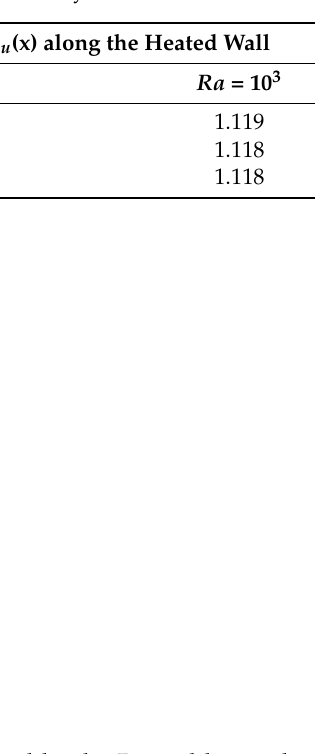
Figure 3. Numerical results comparison with the analytical solution of Shih and Tan [32]. In addition, the average Nusselt number on the hot wall is correlated with the established results (see in Table 2) developed by Chen et al. [33] and De Vahl Davis [34]. Our numerical approach is validated by an excellent comparison. In addition, Figure 4 depicts the computational grid that is used in this investigation. All numerical simulations are performed on a grid that is uniform with a step size h = 0.01. Table 2. Average Nusselt number N u ( x ) comparison with formerly established outcomes.